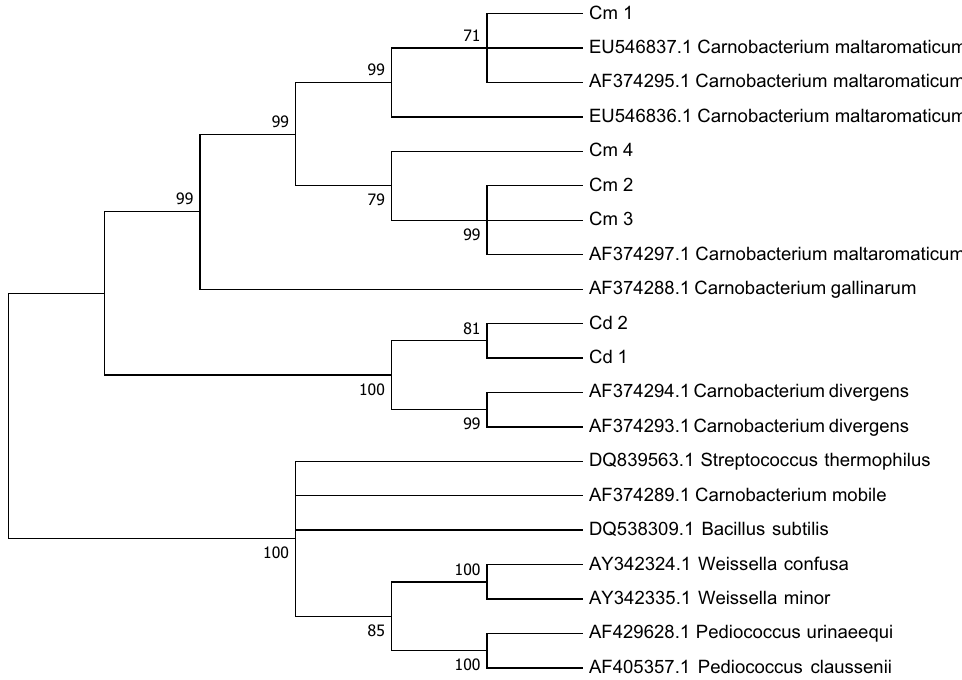
Figure 2. Evolutionary relationships of taxa based on ISR. The evolutionary history was inferred using the neighbor-joining method. Shown is the optimal tree with the sum of branch length of 1.24457936. The percentage of replicate trees in which the associated taxa clustered together in the bootstrap test (1000 replicates) are shown next to the branches; only bootstrap values > 70 are displayed. The evolutionary distances were computed using the maximum composite likelihood method and are expressed as units of the number of base substitutions per site. Analysis involved 20 nucleotide sequences. Codon positions were 1st + 2nd + 3rd + Noncoding. All positions containing gaps and missing data were eliminated. There was a total of 200 positions in the final dataset. Evolutionary analyses were conducted in